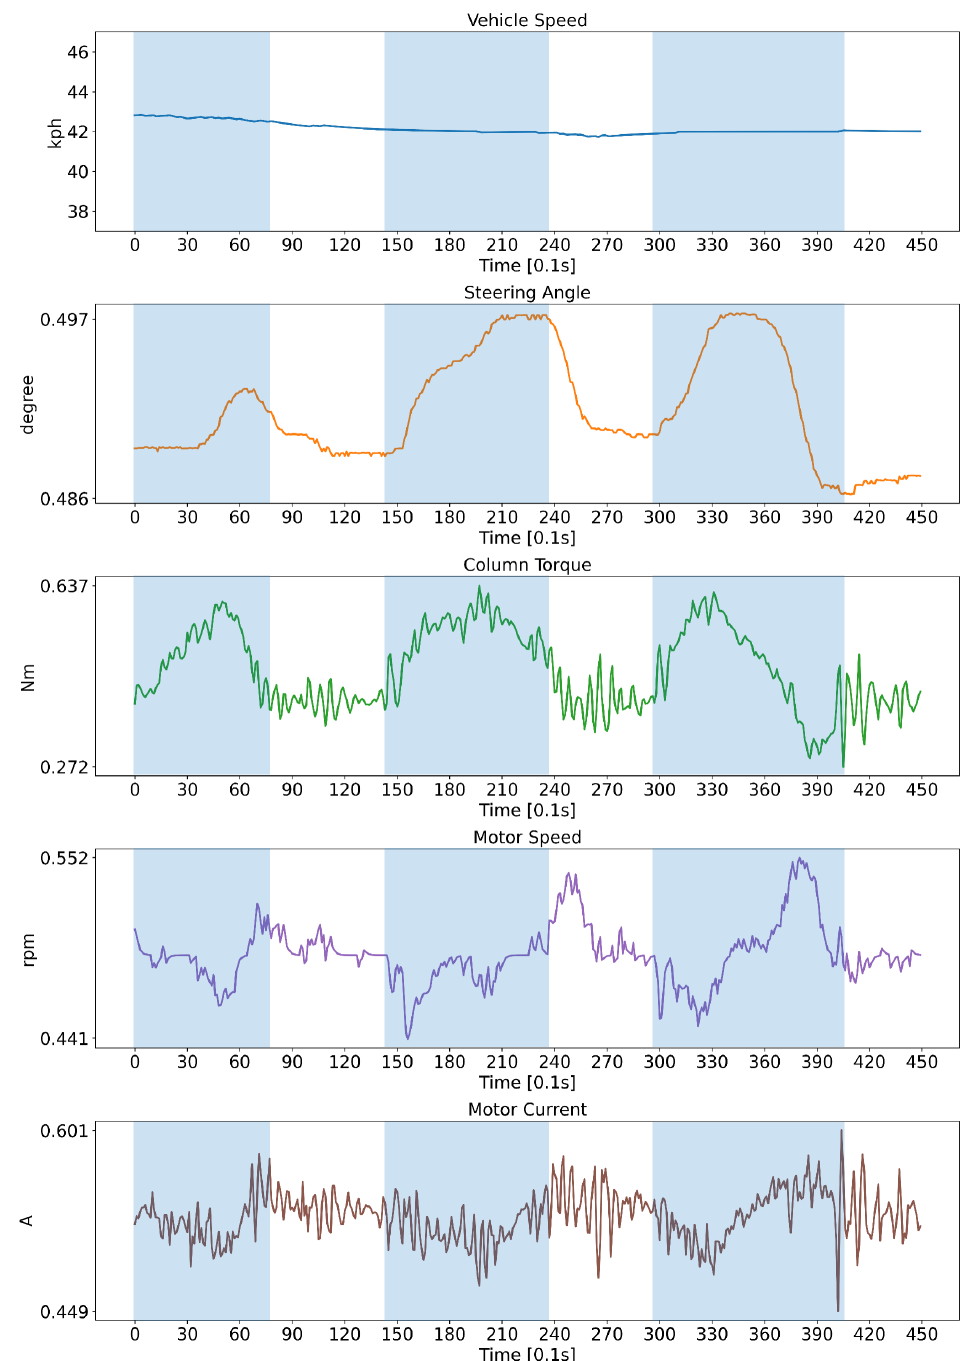
Figure 4. An example of collected data. Hands on and hands off state was shown as blue and with transparent background, respectively. All signals except for vehicle speed were min-max